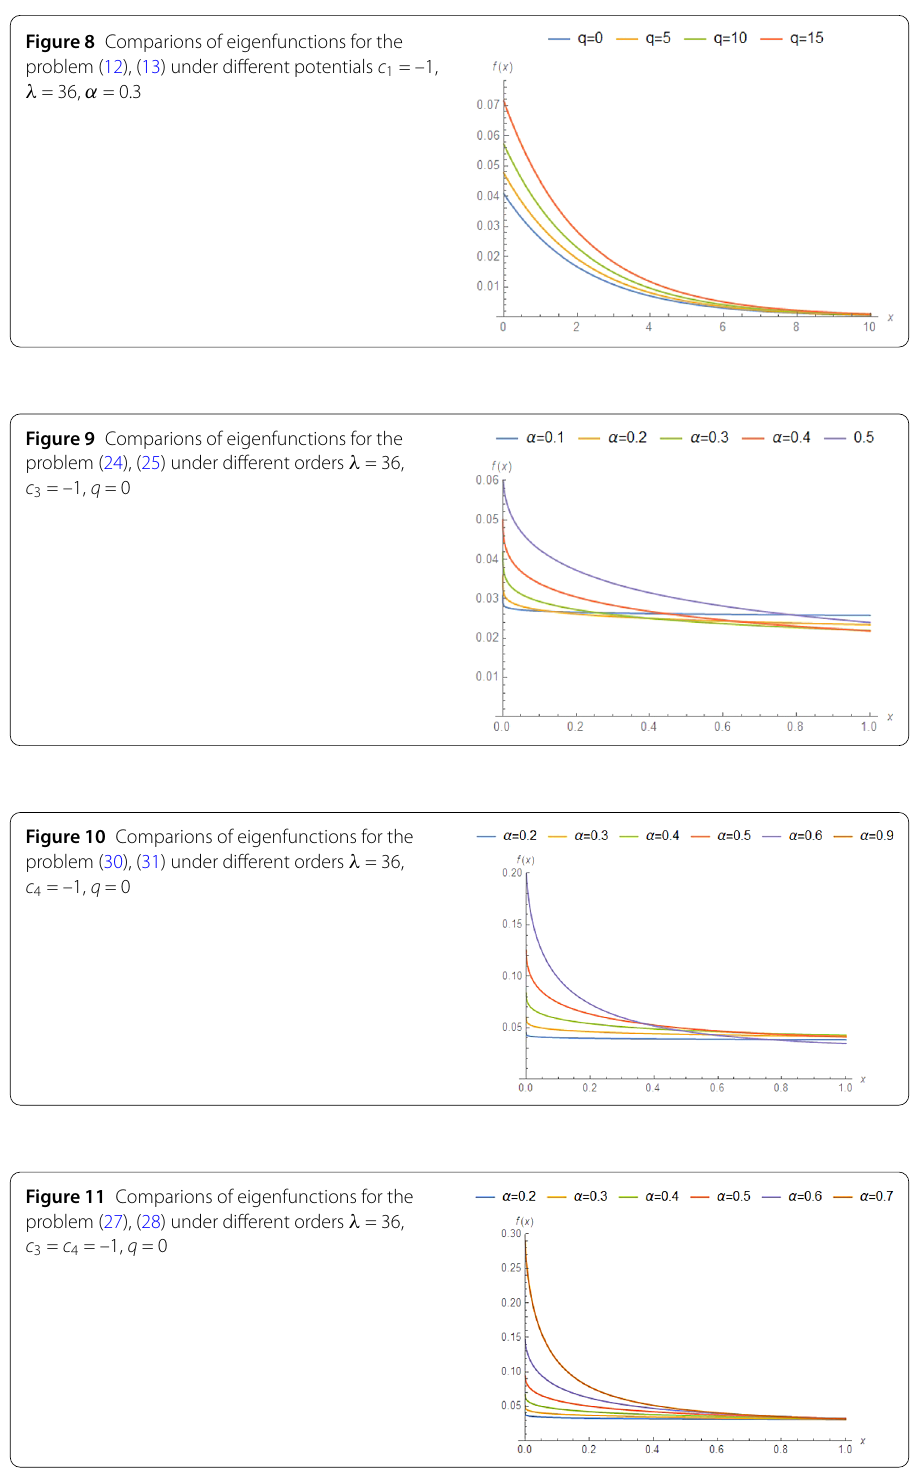
Figure 8 Comparions of eigenfunctions for the problem (12), (13) under different potentials c 1 = –1, λ = 36, α = 0.3